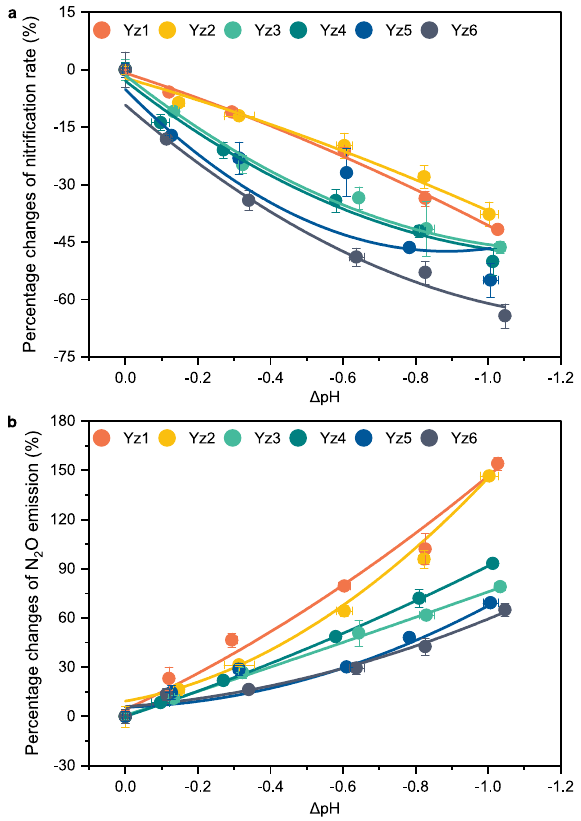
Fig. 2 | Response of nitri fi cation and associated N 2 O production rates to simulated aquatic acidi fi cation in Yangtze Estuary and its adjacent coastal area.a Nitri fi cationrates.Datashowthepercentagechangesofnitri fi cationratesin theacidi fi edtreatmentscomparedtotheambientcontrol.Forallthelines, P <0.05. b N 2 O production rates. Data show the percentage changes of N 2 O production ratesinthe acidi fi ed treatments compared tothe ambient control.Forallthe lines, P <0.05. Error bars represent SD ( n =3 biologically independent samples). Δ pH corresponds to the decrease between water pH before and after acidi fi cation. The fi ttingcurvewasobtainedbypolynomial fi ttingmethod.Equationsand P valuesfor the fi ttedcurvesaregiveninSupplementaryTable 3.Sourcedataareprovidedasa source data fi